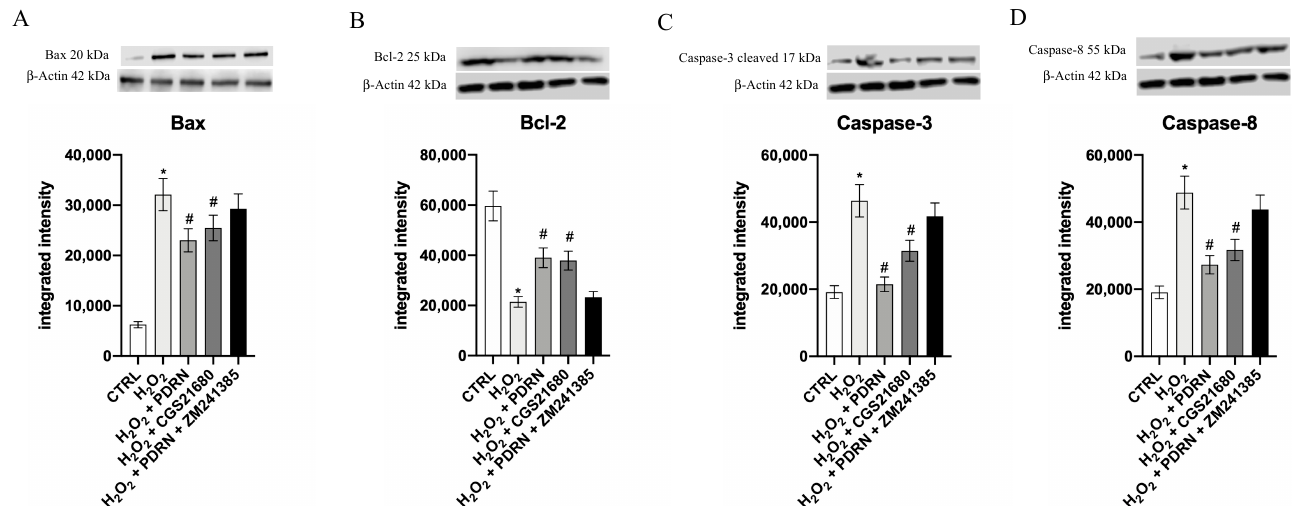
Figure 5. The graphs represent the gene expression results of Bax ( A ), Bcl-2 ( B ), Caspase-3 ( C ) and Caspase-8 ( D ) in IHCE cells. The values are expressed as the means and SD. * p < 0.0001 vs. CTRL; # p < 0.0001 vs. H 2 O 2 .